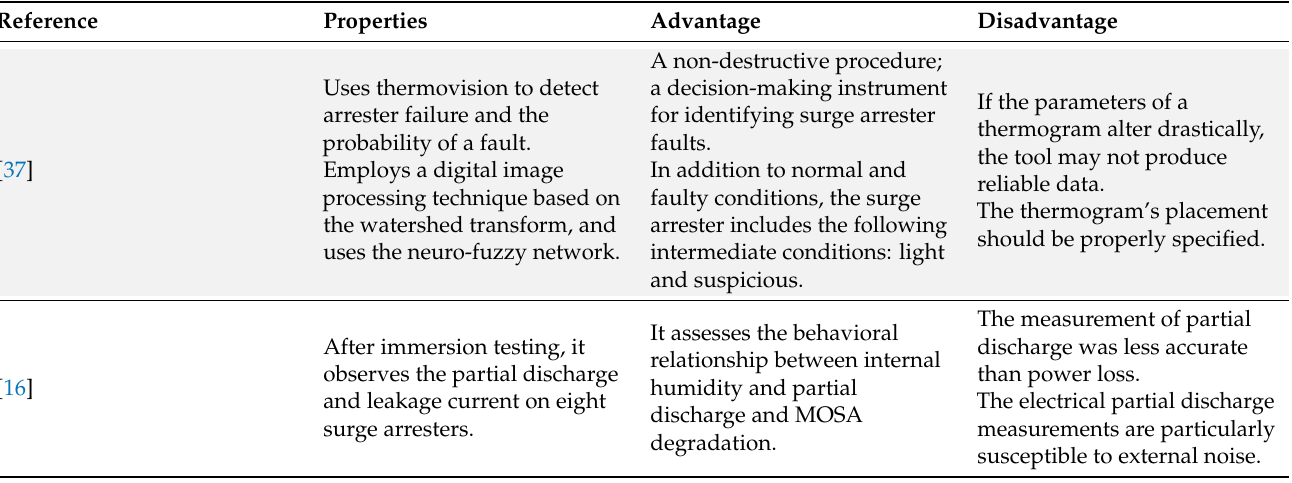
Table 2. Comparison of properties, advantages, and disadvantages of MOSA diagnostic methods in different